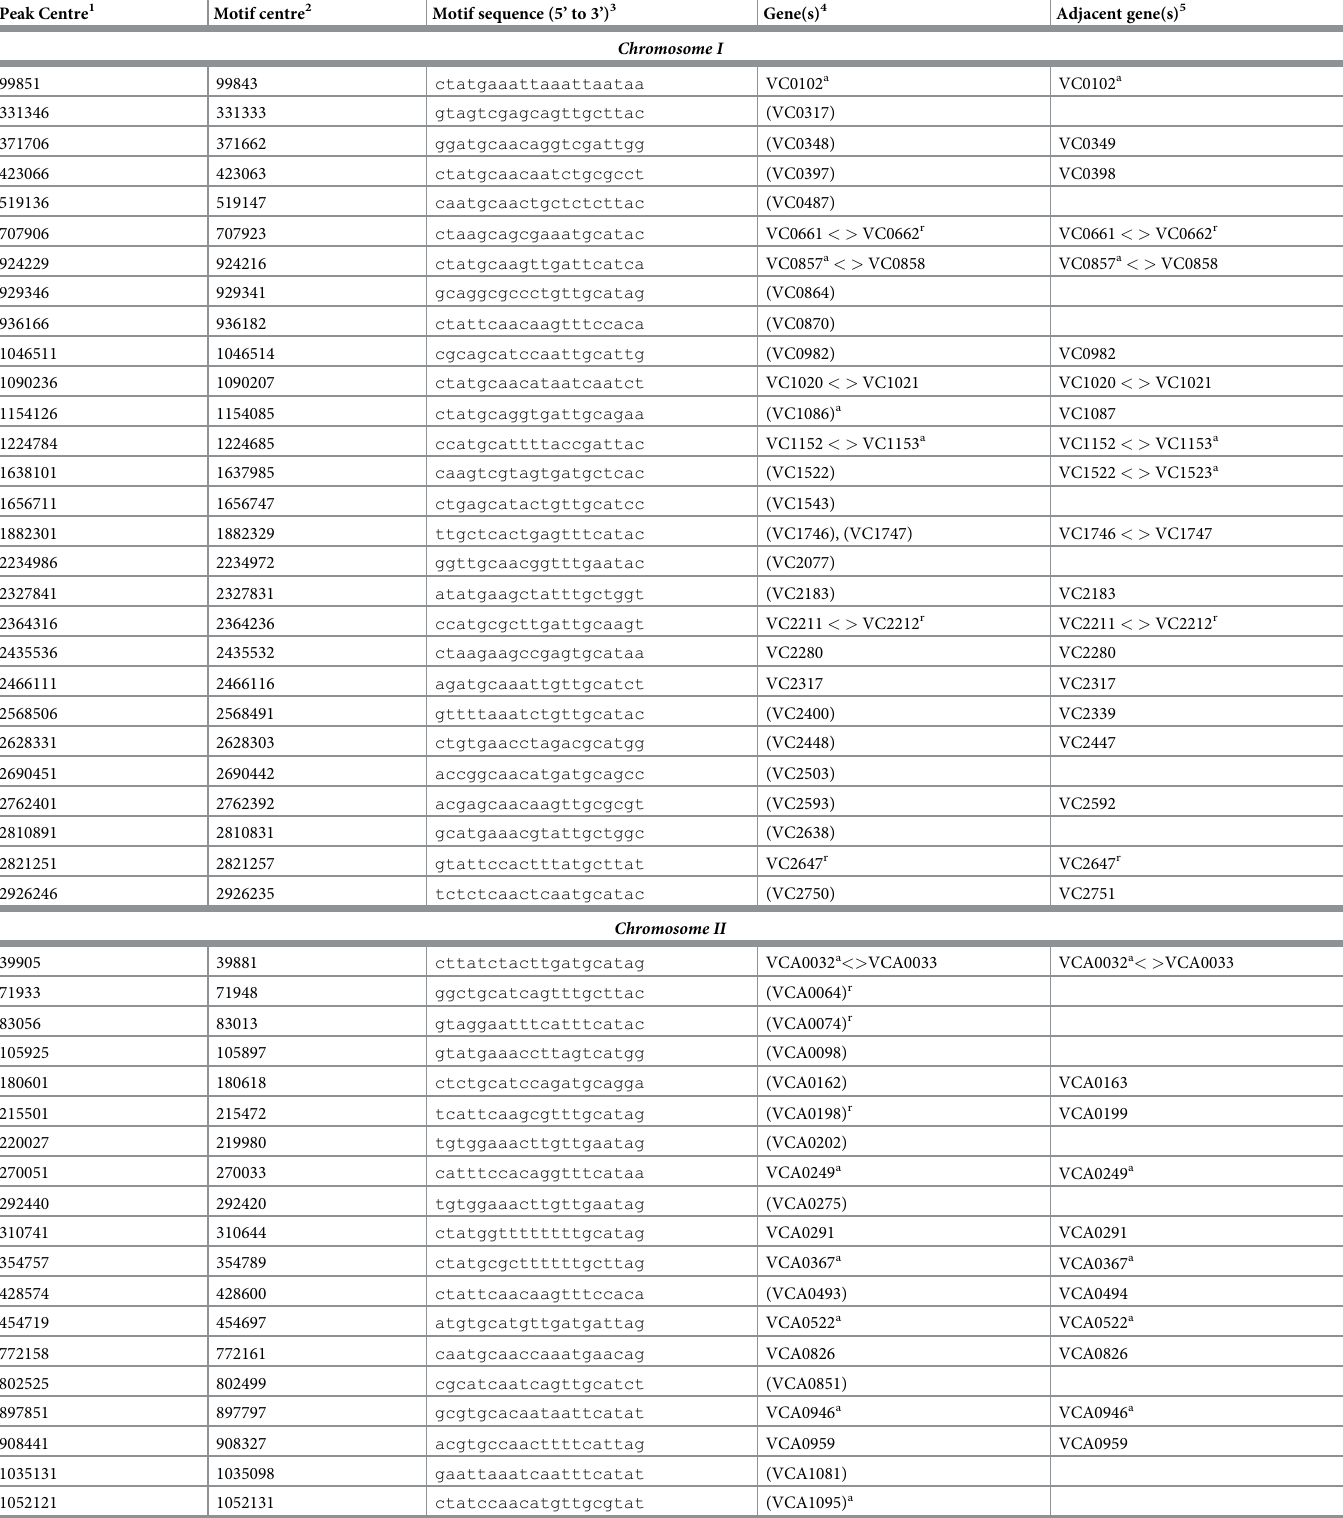
Table 1. Position and sequence of AphA binding sites across the V . cholerae genome. Peak Centre